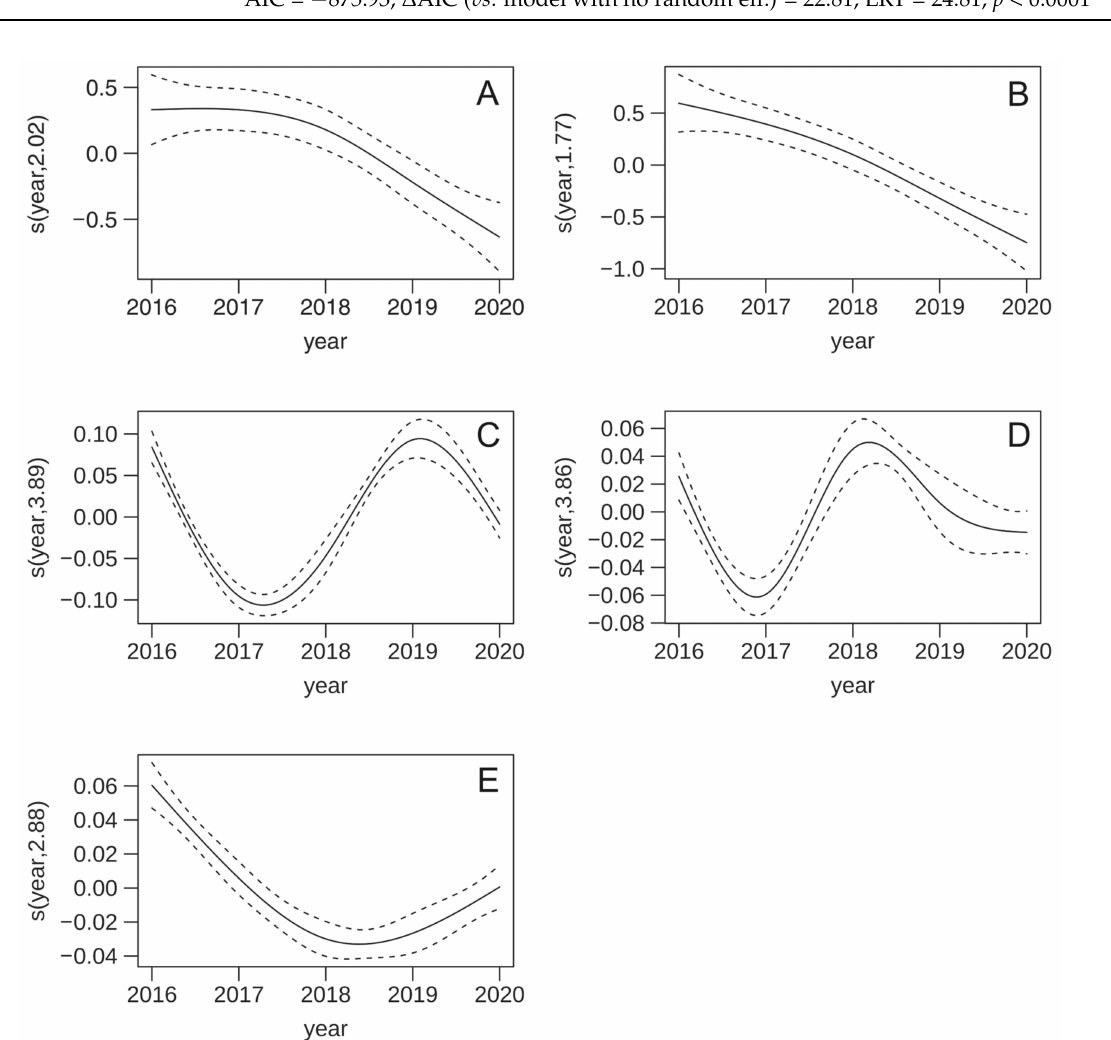
Figure 2. Estimated smoothing curve (solid line) and 95% confidence bands (dashed lines) for year effect in the different models in Table 2 for maximum capture ( A ), total capture ( B ), day at max capture ( C ), day at first capture ( D ), and day at last capture ( E